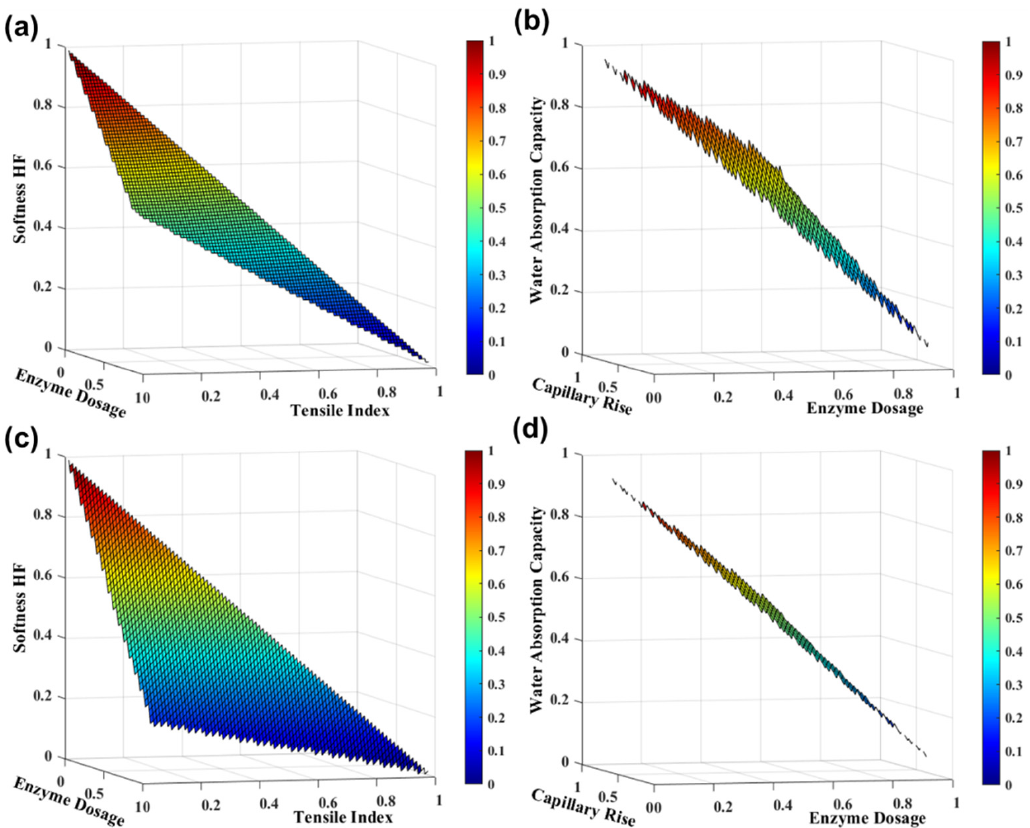
Figure 6. TSA-softness HF and tensile index properties ( a , c ) and water absorption capacity and capillary rise ( b , d ) with enzyme dosage in an enzymatic pretreatment process followed by 500 PFI revolutions at 3.33 N/mm ( a , b ) and pre-refining at 500 PFI revolutions at 3.33 N/mm, followed by enzymatic treatment ( c , d ). The variables were normalized.